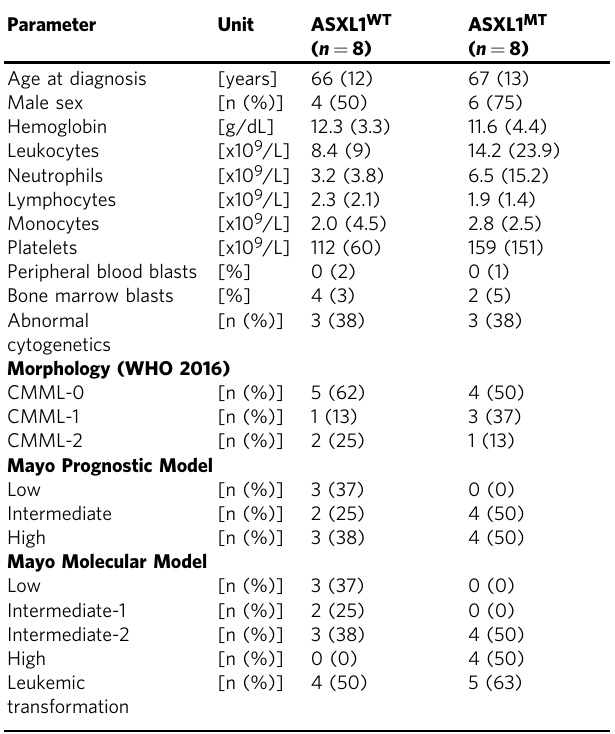
Table 1 Clinical characteristics of 16 patients with CMML strati fi ed by ASXL1